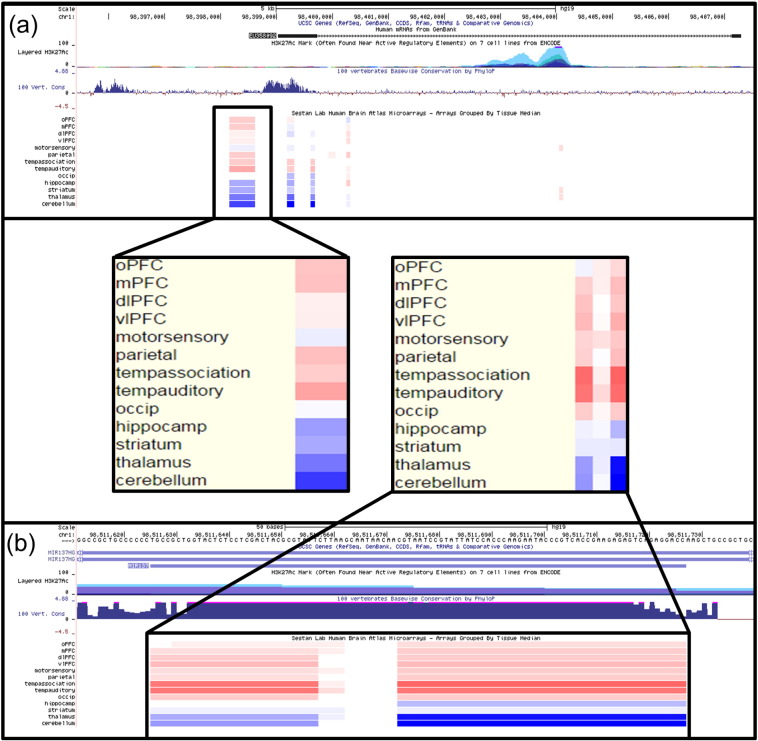
Comparison of MIR137 and EU358092 expression in vivo.(a) Sestan lab brain microarray expression data (accessible through UCSC Genome Browser) for EU358092 showed expression (red) in the orbital and medial prefrontal cortices, as well as the parietal, temporal association and temporal auditory cortices. No expression (blue) of EU358092 was seen in the hippocampus, striatum, thalamus, or cerebellum.(b) Brain microarray data showed MIR137 expression across regions of the prefrontal cortex, including the medial, dorsolateral, and ventrolateral regions, as well as being most highly expressed in the temporal association and temporal auditory cortices. MIR137 was not found to be expressed in the thalamus or cerebellum. The similar expression patterns of EU358092 and MIR137 across brain regions may suggest a co-ordinated pattern of expression for genes at this locus, pointing to a potentially important brain-related function for EU358092.